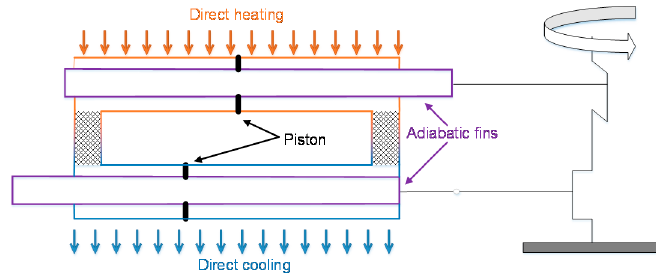
Figure 4. The proposed adiabatic fins inside the Franchot engine cylinders.